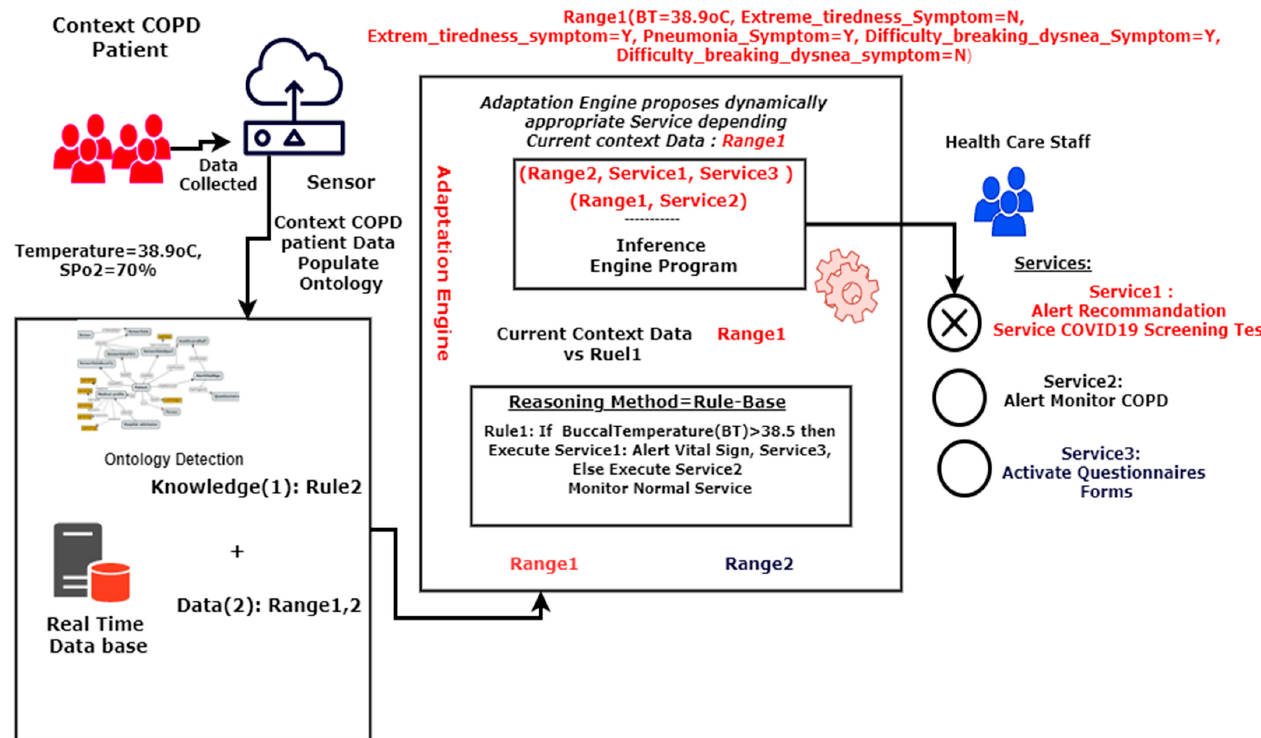
Figure 14. Adaptation mechanism that delivers an alert recommendation for the screening test.